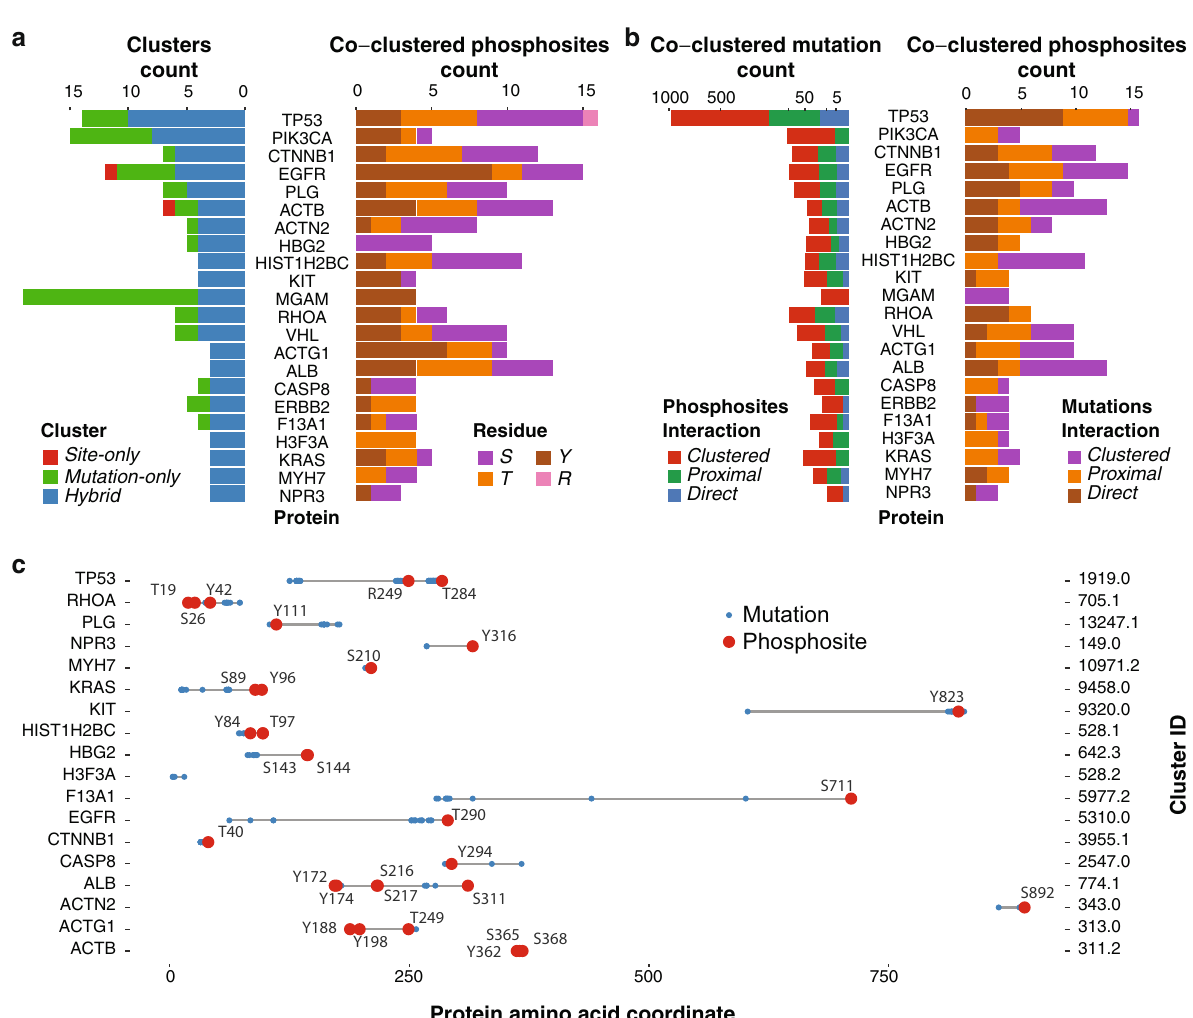
Fig. 2 Hybrid clusters containing both phosphosites and mutations. a Left shows the counts of hybrid clusters, mutation-only clusters, and site-only clusters in genes with at least two hybrid clusters. Right barplot shows counts of each type of phospho-residue, being serine (S), threonine (T), tyrosine (Y), or Arginine (R), found in hybrid clusters for each of the genes. b Spatial interactions of co-clustered mutations and phosphosites. For each of the genes, we counted how many of the co-clustered mutations and phosphosites are also directly overlapping (Direct) or within 2 amino acid residues (Proximal), and without any of these apparent linear relationships (Clustered) to phosphosites and mutations, respectively, in the same hybrid clusters. c Phosphosite and mutations on the linear protein coordinate of top hybrid clusters as de fi ned by cluster closeness scores in each of the highlighted genes (excluding HIST1H4G and H3F3A due to their top hybrid clusters included phosphosites from other proteins and excluding MGAM due to its top clusters located at residue coordinate beyond the plotted range [centroid at 1514]). The Ensembl transcripts used for mapping of the protein coordinates are described in Supplementary Data